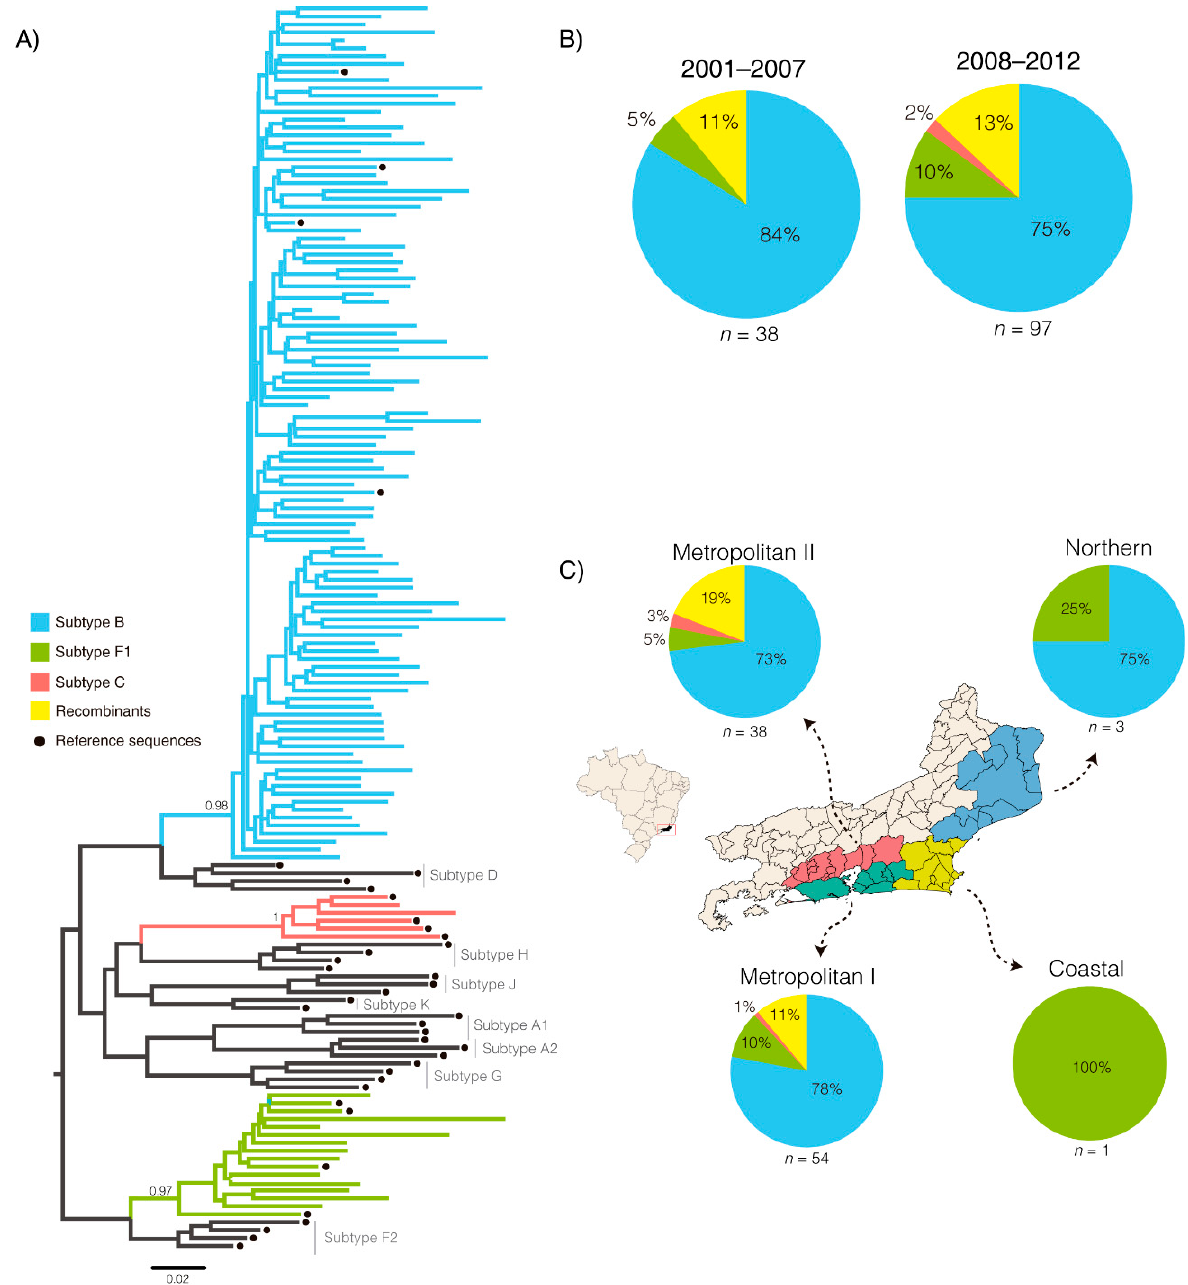
Figure 1. Subtype classification of the pol (PR/RT) region of HIV-1 from infected children and adolescents from Rio de Janeiro. ( A ) Maximum likelihood tree of the HIV-1 strains classified as “pure” subtypes. Reference sequences retrieved from the Los Alamos HIV-1 data base were indicated by black circles. The branches were colored according to the legend at left. aLRT values are shown only at key nodes. The scale represents number of substitutions per site. ( B ) Pie charts representing HIV-1 molecular diversity found in the two time periods. ( C ) Map of Rio de Janeiro state colored according to different regions indicating the local HIV-1